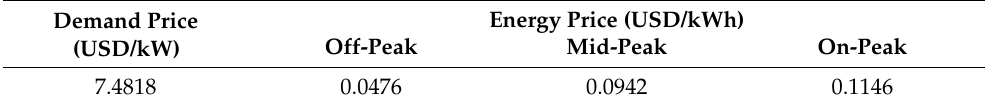
Table 2. Time-of-use tariff of Korea electric power company